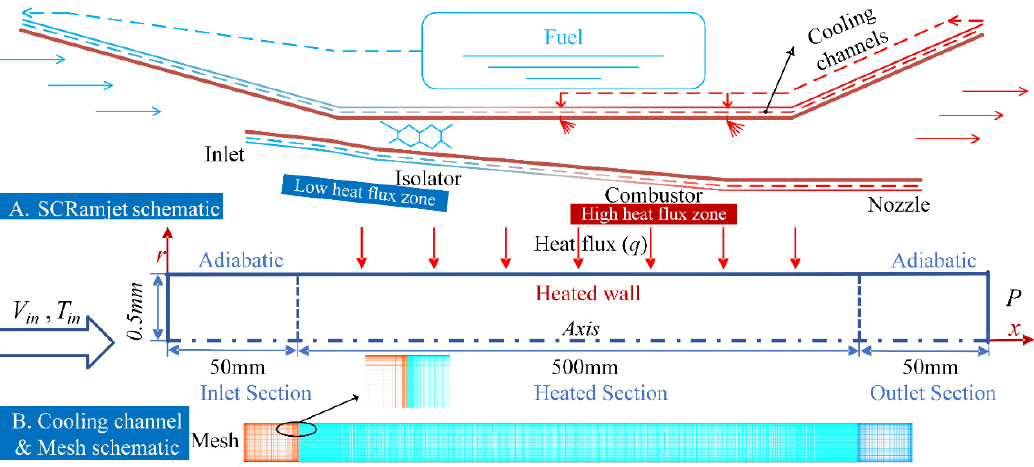
Figure 2. Schematic diagram of regenerative cooling ( A ) and the cooling channel mesh ( B ) in SCRamjet.